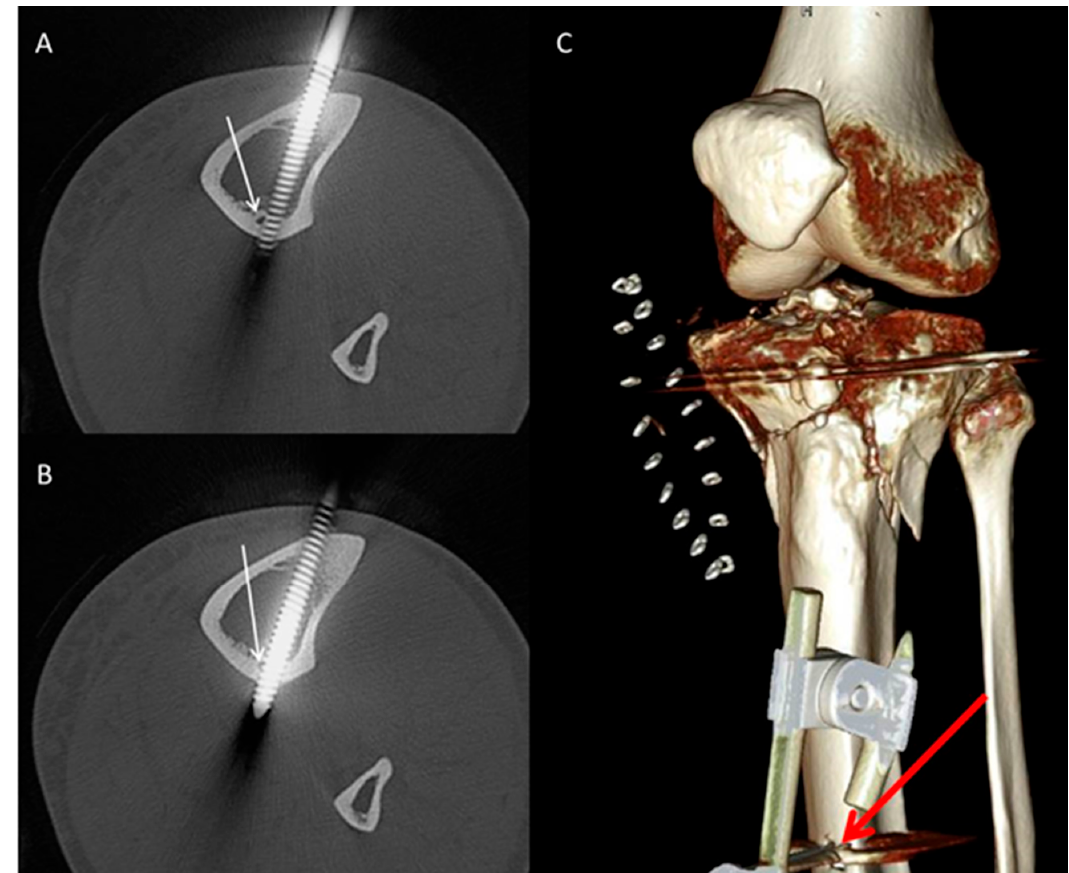
Figure 4. Subsequent axial ( A , B ) reformatted images in the bone window showing partial disruption of the tibial nutrient artery canal (white arrow) by the proximal pin of a knee spanning external fixator. ( C ) Three-dimensional reconstruction illustrating the anteromedial application of the pin (bold red arrow).